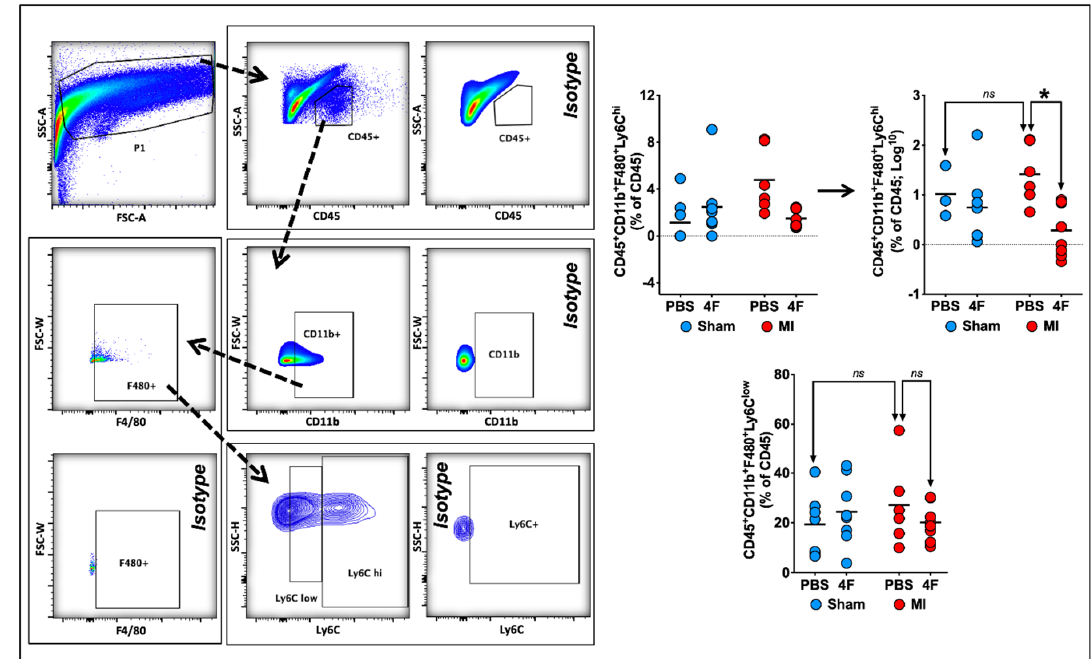
Figure 4. L-4F decreases myocardial pro-inflammatory macrophage expansion in infarcted hearts. Left panel: Gating strategy for flow cytometric evaluation of cardiac macrophages. Right panel: Quantitative group data for macrophage abundance in sham-operated and infarcted hearts after PBS or L-4F treatment for 5 days, starting at 3-day post-surgery. Statistical comparisons were performed after logarithmic data transformation to satisfy the normality assumption as described in the text. Data are presented as percent CD45 + cells by flow cytometry, n = 6–8 / group, * p < 0.05. ns—not